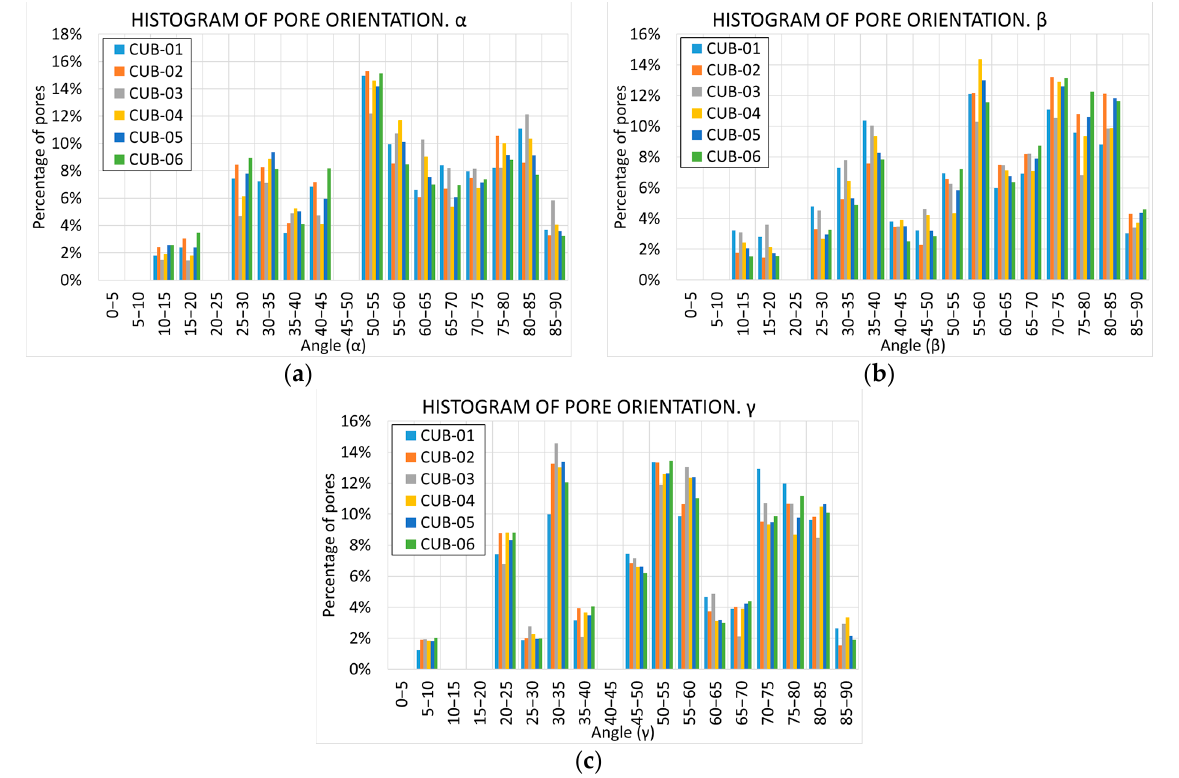
Figure 25. Histograms of pore orientation of the angles α , ( a ) β ( b ) and γ ( c